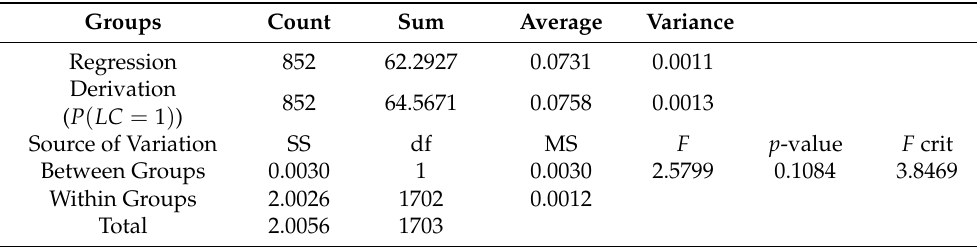
Table 1. Summary statistics for the prediction of single LC events based on the test of Analysis of Variance (ANOVA).